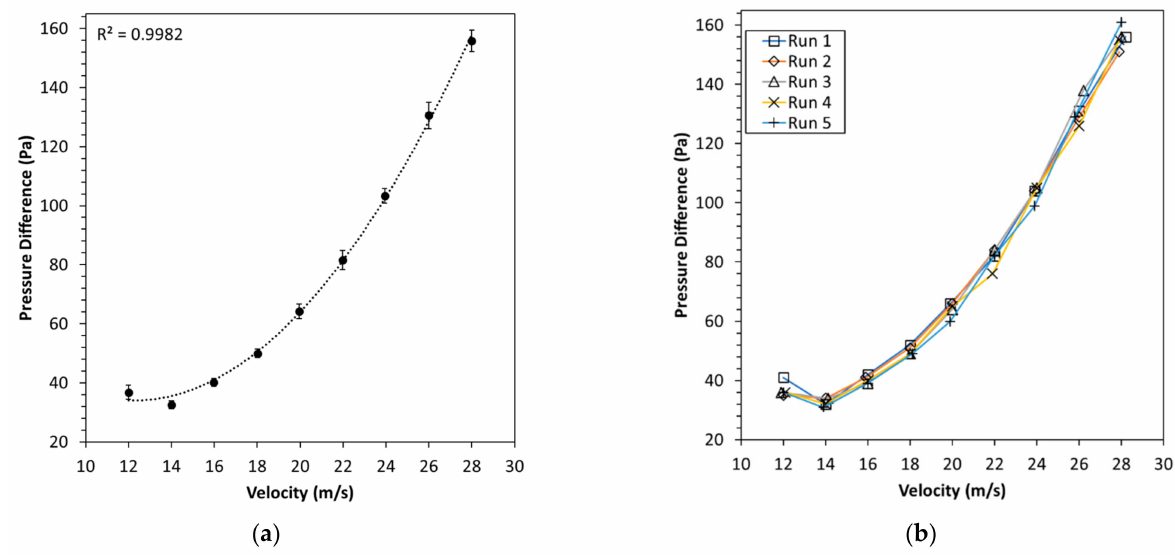
Figure 8. Experimental results for 2 mm dimples engraved on the NACA/elliptical Profile; ( a ) average of 5 runs; ( b ) 5 indi- vidual runs.